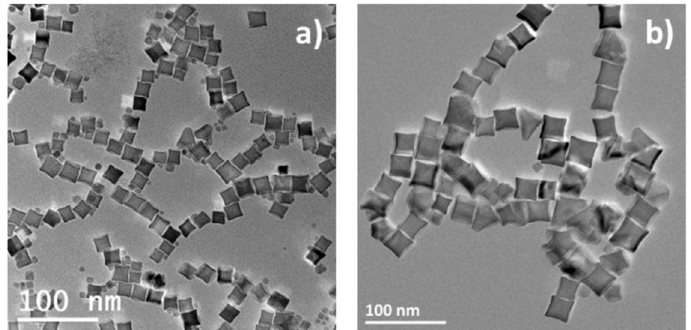
Figure 3. Transmission electron microscopy (TEM) images of the 18 nm octopods ( a ) and 28 nm octopods ( b ).